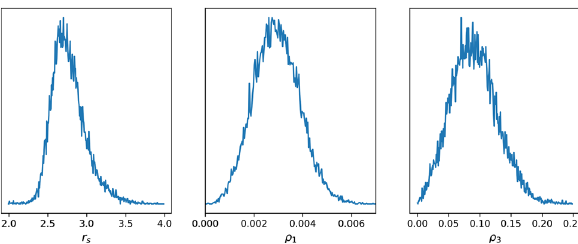
Fig. 2 Marginalized posterior distributions for the parameters charac- terizing the halo derived from the monopole of the neutral scalar field